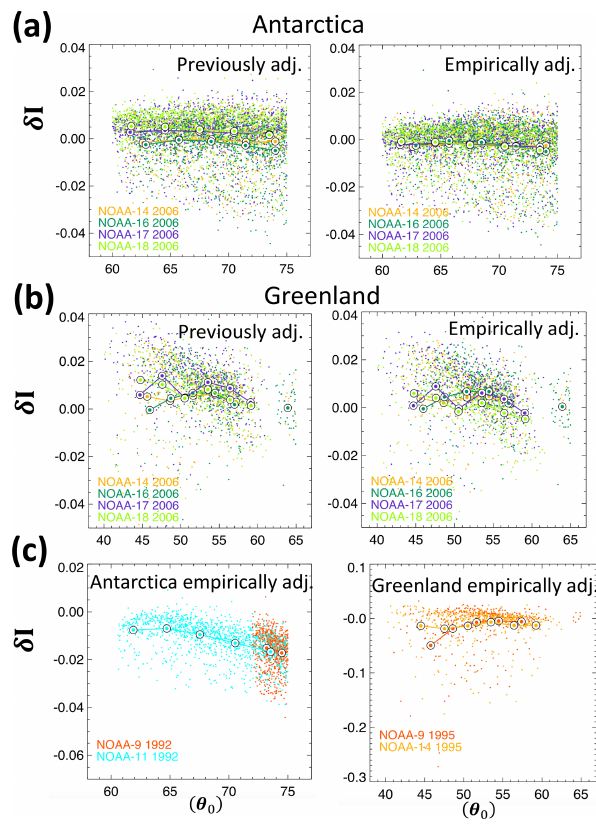
Figure 3. δI for all FOVs observed over the ice sheets plotted against solar zenith angle ( θ o ) for specific years. The large circles are averages of δI binned by solar zenith angle. Panel (a) shows the previously calibrated δI on the left and our empirically calibrated δI over Antarctica on the right for 2006. Panel (b) is the same but over Greenland for 2006. Panel (c) shows our empirically calibrated values over Antarctica in 1992 and Greenland in